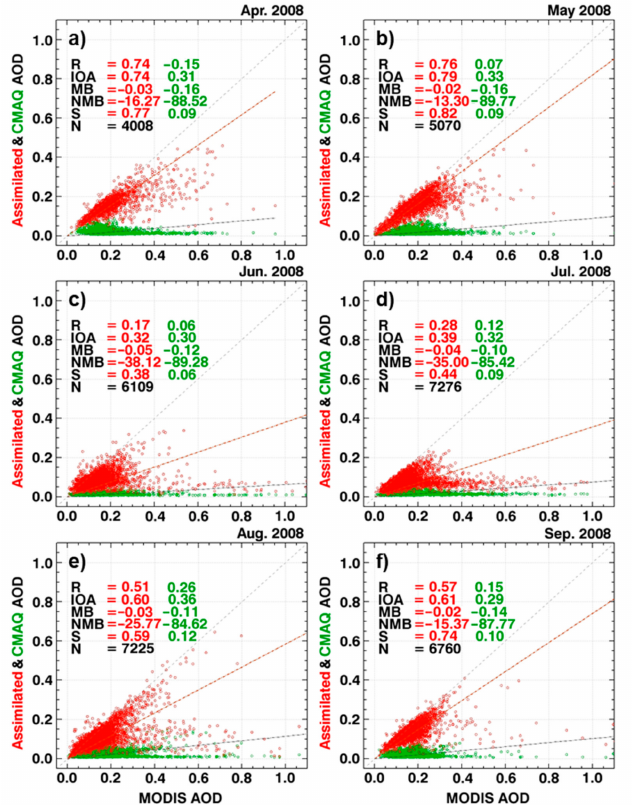
Figure 3. Scatter plots and statistical analysis between τ MODIS and τ CMAQ and τ assimilated over the entire domain for ( a ) April, ( b ) May, ( c ) June, ( d ) July, ( e ) August, and ( f ) September 2008. The statistical analysis of R (correlation coefficient), IOA (index of agreement), MB (mean bias), NMB (normalized mean bias, %), S (slope), and N (number of data) was